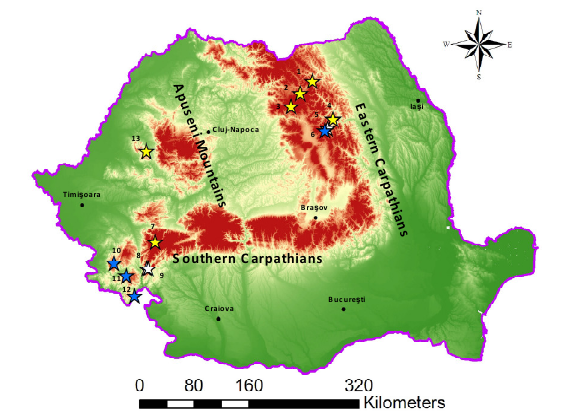
Fig. 2. Chorological map of Asplenium adulterinum distribution in South-Eastern Carpathians; the white star represents certain location, the blue star represents possible locations, the yellow star represents uncertain locations of A. adulterinum in the Romanian Carpathians Legend: 1-Rarău Mountains; 2-Bistriţei Mountains; 3-Călimani Mountains; 4-Ceahlău Mountains; 5,6-Hăşmaş Mountains; 7-Ţarcu Mountains; 8-Cernei Mountains; 9-Mehedinţi Mountains; 10,11- Aninei Mountains; 12-Almăjului Mountains; 13-Codru-Moma Mountains.